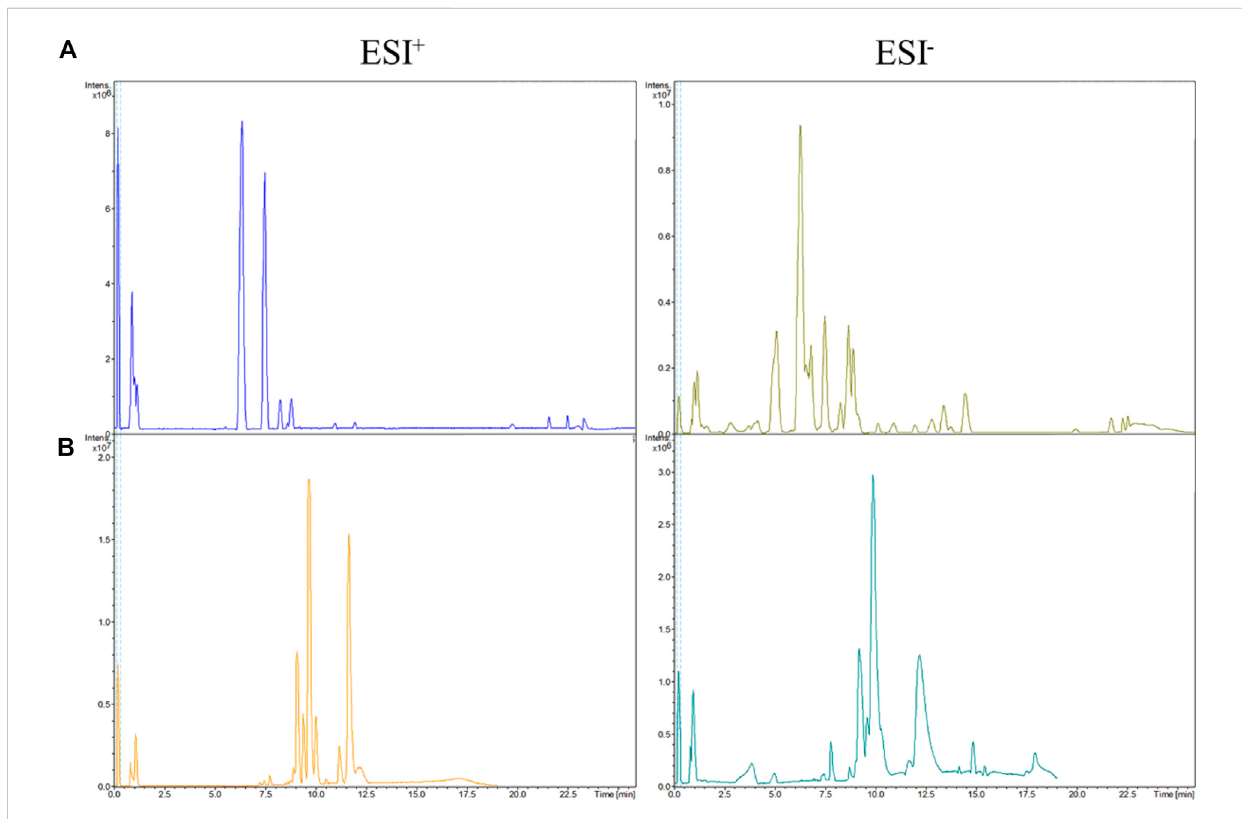
FIGURE 2 Base peak chromatograms in ESI + and ESI − modes. (A) urine QC, (B) serum